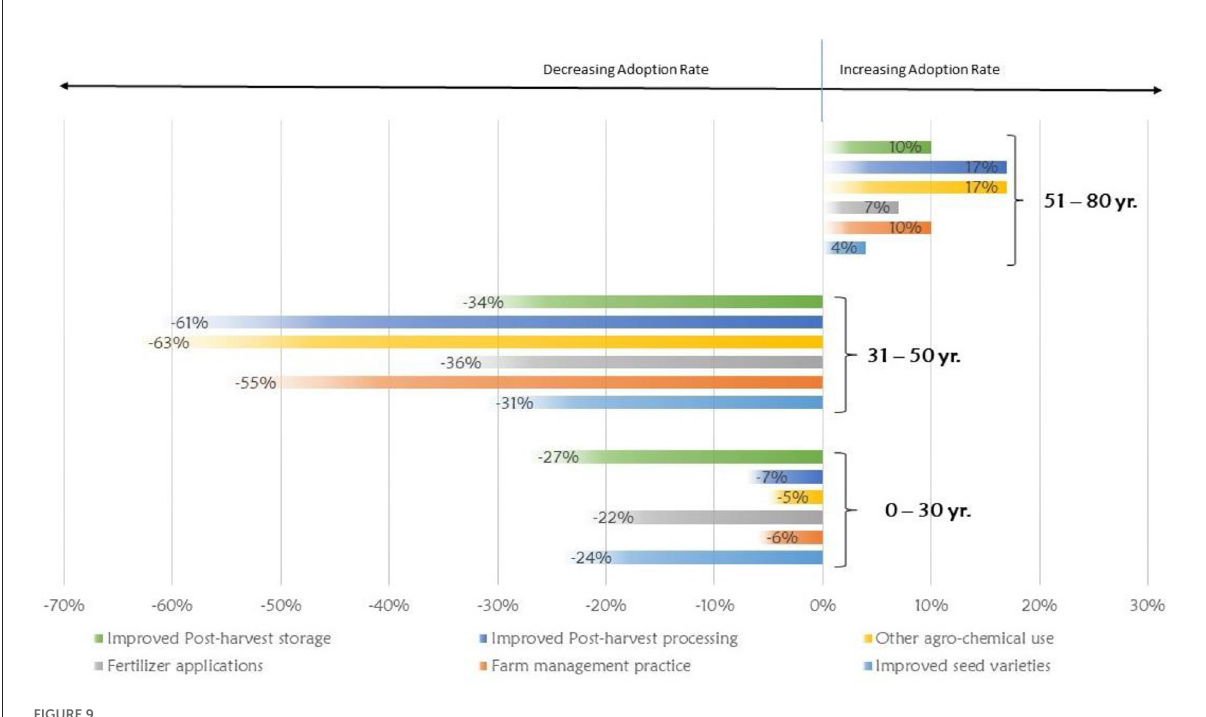
FIGURE9 Variance analysis of technology adoption per age range. Authors,